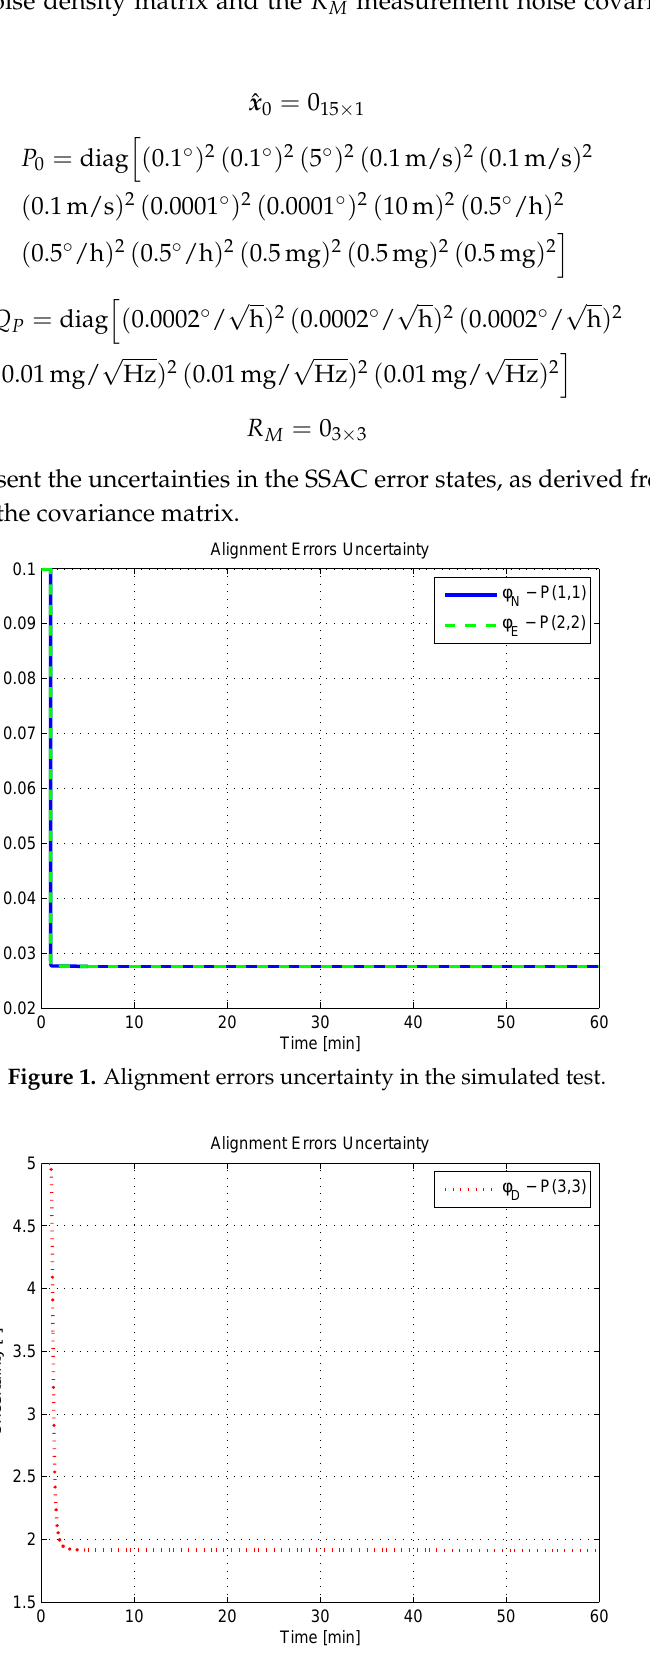
Figure 2. Alignment errors uncertainty in the simulated test,